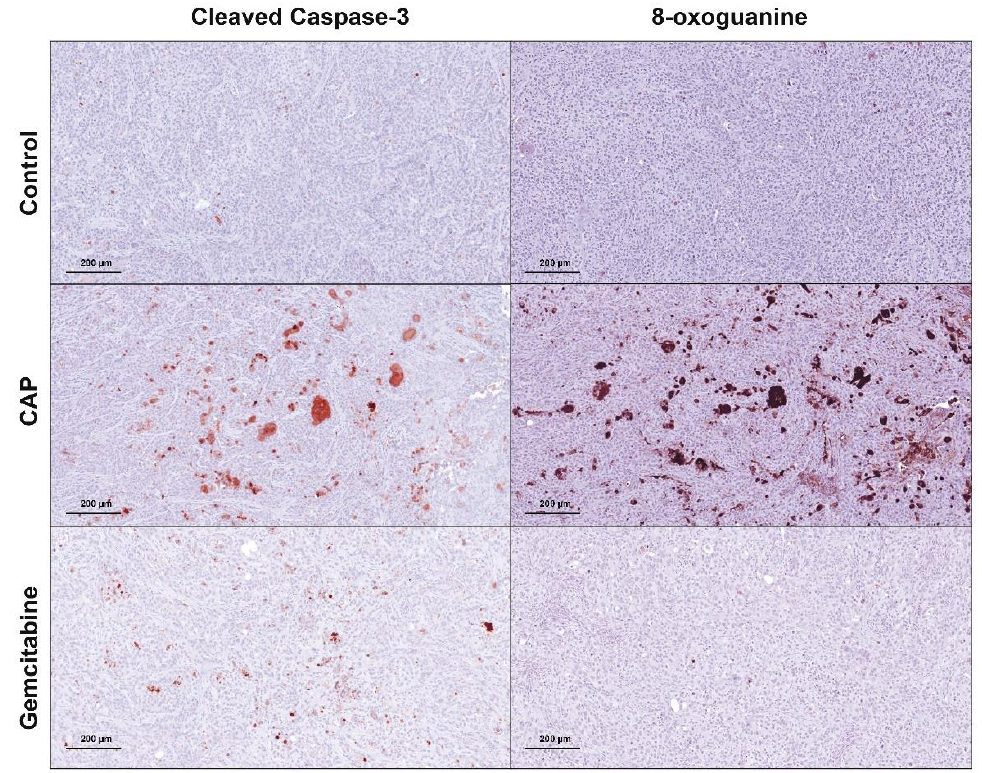
Figure 3. Representative IHC staining of cleaved caspase-3 and 8-oxoguanine in control (upper panel), CAP (middle panel) and gemcitabine (bottom panel) treated xenograft tumors. Magnification, ×250. Scale: 200 μm.